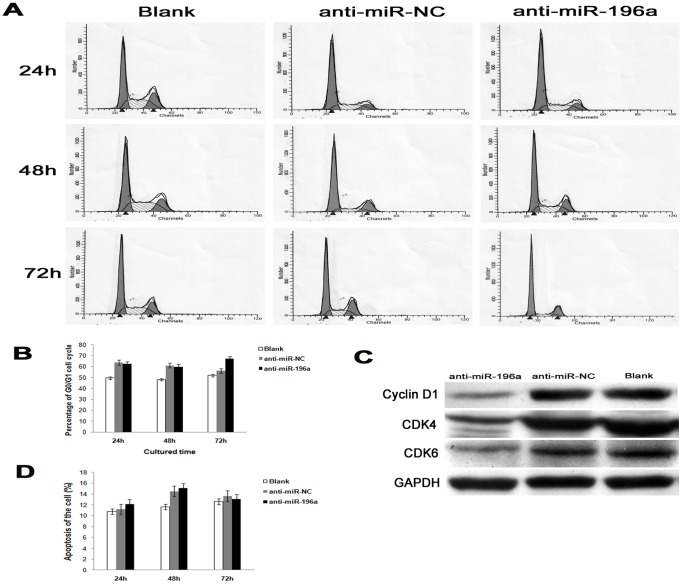
Repression of miR-196a increased G0/G1 phase but had no effect on apoptosis of PANC-1 cells.(A) Representative flow cytometry analysis of cell cycle in PANC-1 with and withdrawl silencing miR-196a at 24 h, 48 h and 72 h. (B) Comparison of cell cycle among anti-miR-196a, anti-miR-NC and Blank. The percentage of cells at G0/G1 phase at 72 h was increased from (56.07±7.93)% (anti-miR-NC) to (67.20±3.12)% (anti-miR-196a) (*, P<0.05), while there was no statistic significance in G0/G1between anti-miR-196a group and anti-miR-NC group at 24 h and 48 h. (C) Representative western blot analysis showed downregulation of Cyclin D1 and CDK4/6 expression after suppression of miR-196a in PANC-1 cells at 72 h. (D) Comparison of apoptosis among anti-miR-196a, anti-miR-NC and Blank.